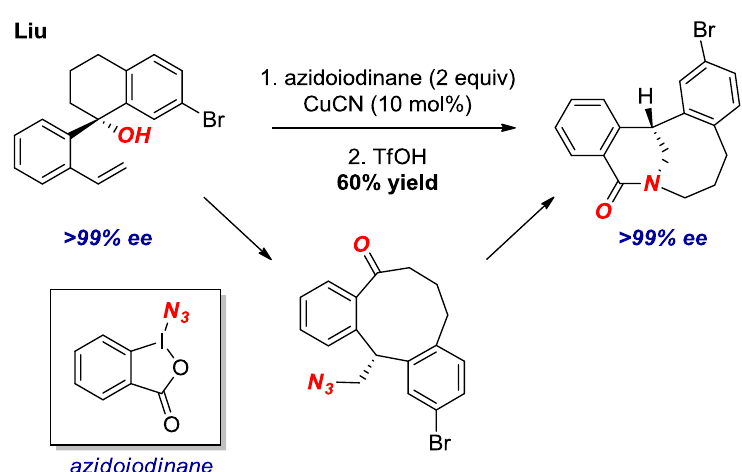
Figure 15. Enantioselective Synthesis of Bridged Lactams by Radical Aryl Migration.